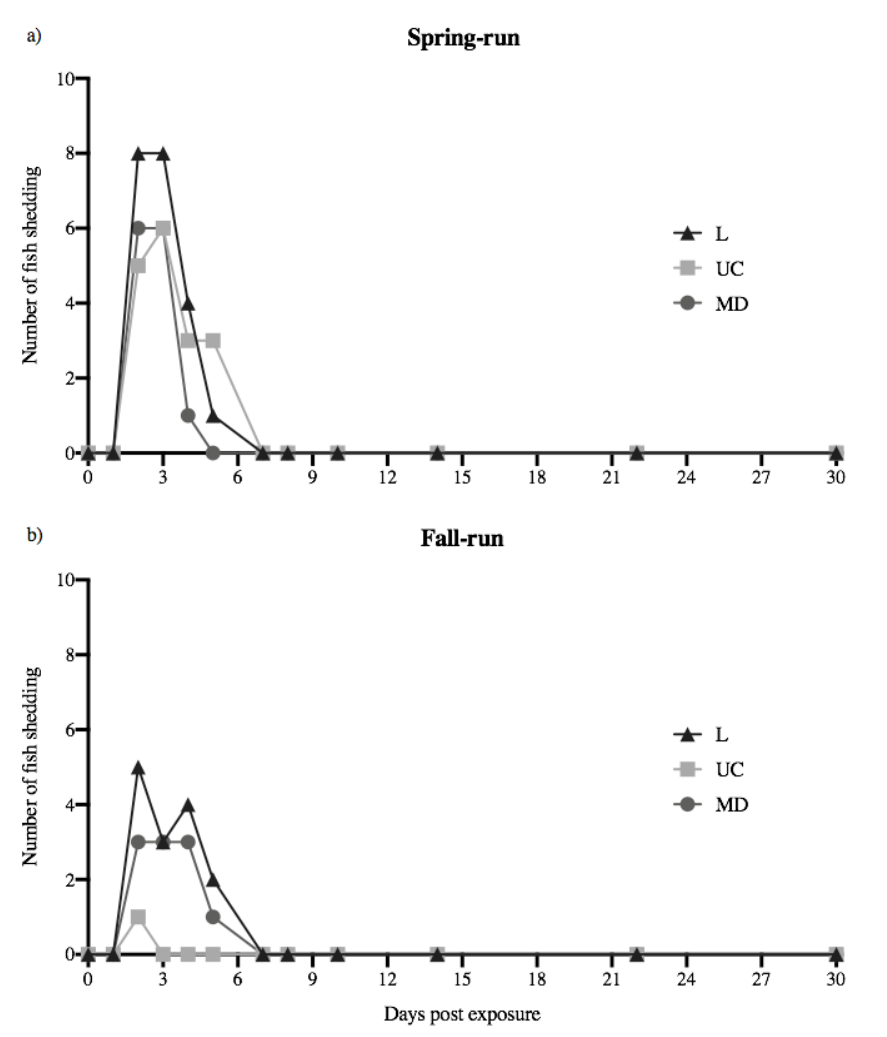
Figure 1. Daily number of fish shedding detectable virus over the 30-day course of infection. Spring- ( a ) and fall-run ( b ) Chinook salmon shedding L, UC and MD IHN virus per day, out of 10 fish in each treatment group. No fish in the virus-free treatment (negative control) shed detectable virus over the course of the 30-day experiment.